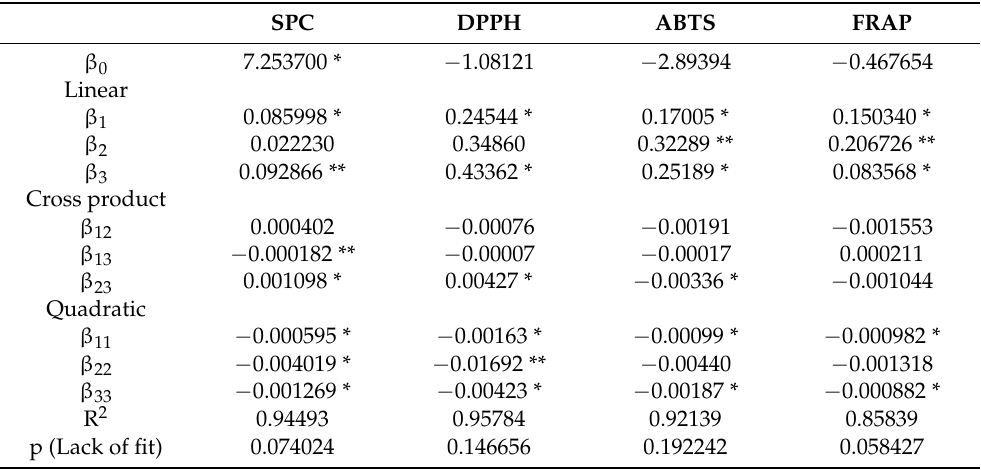
Table 3. Regression coefficients and analysis of variance (ANOVA) of the model for the response